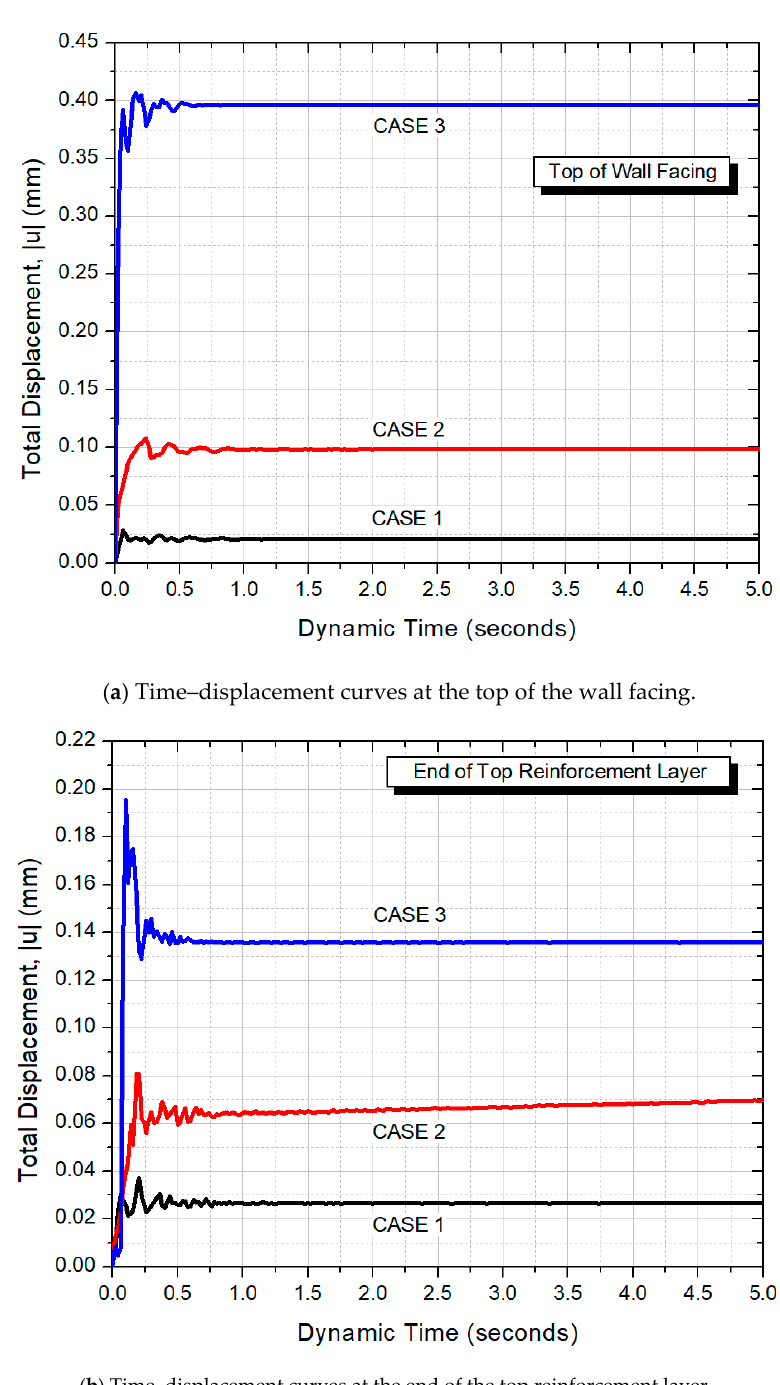
Figure 15. Time-displacement curves at the top of the wall due to seismic load.